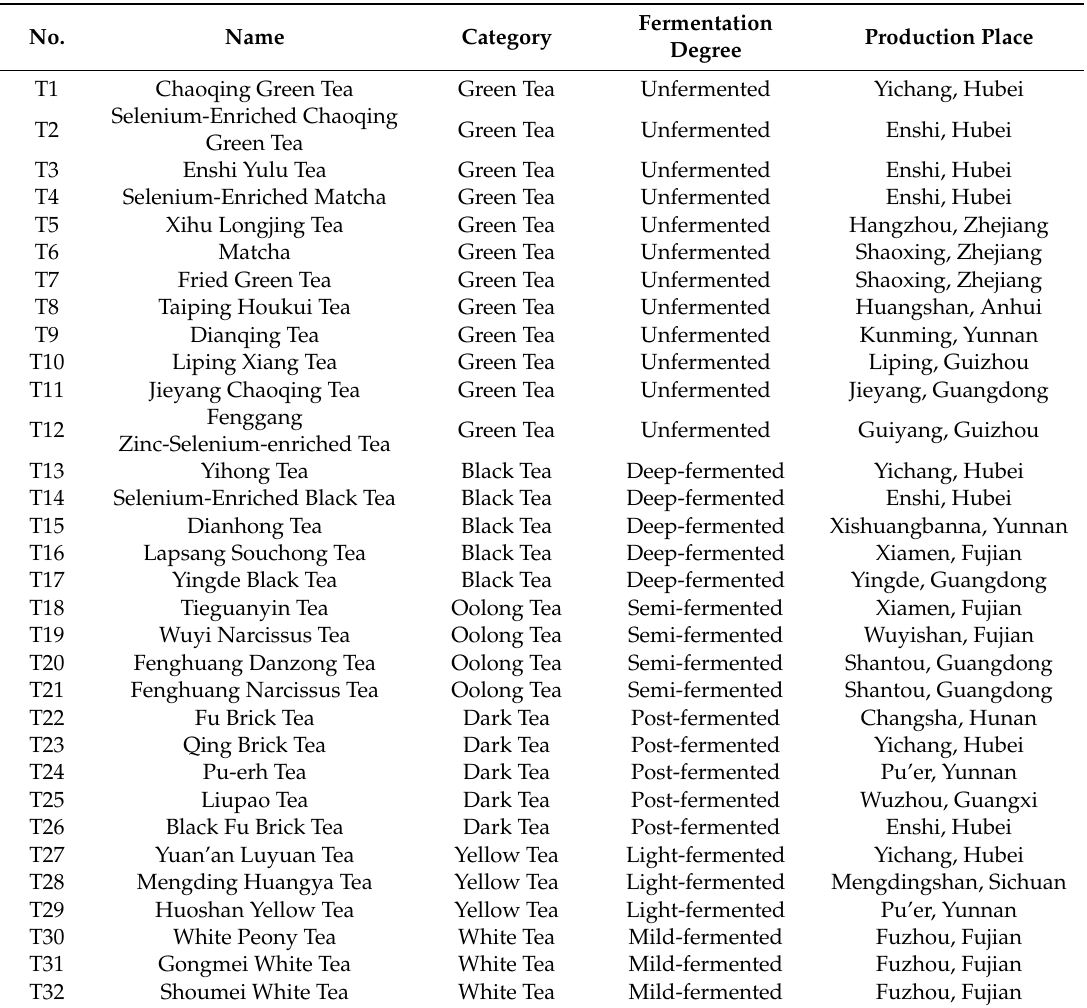
Table 1. The information of 32 selected Chinese